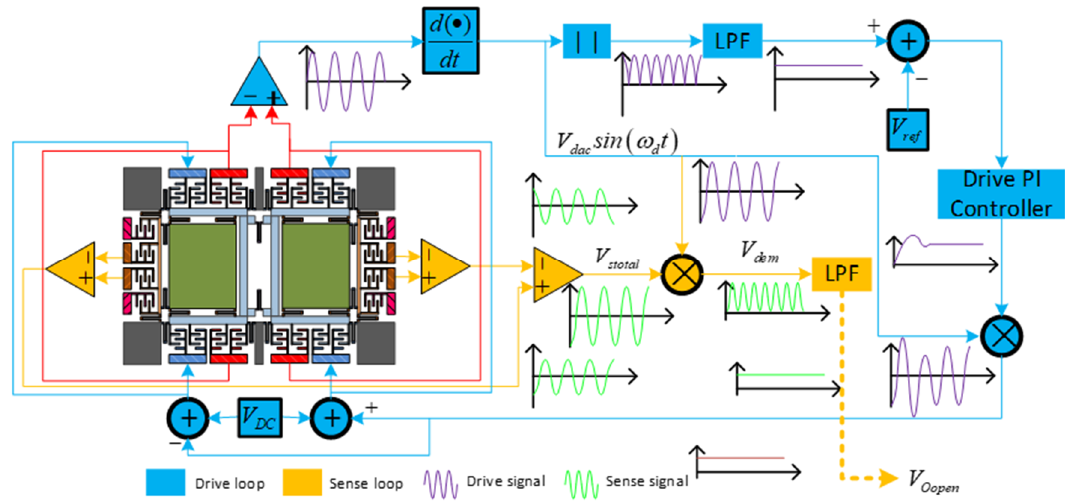
Figure 3. Gyroscope system schematic diagram.